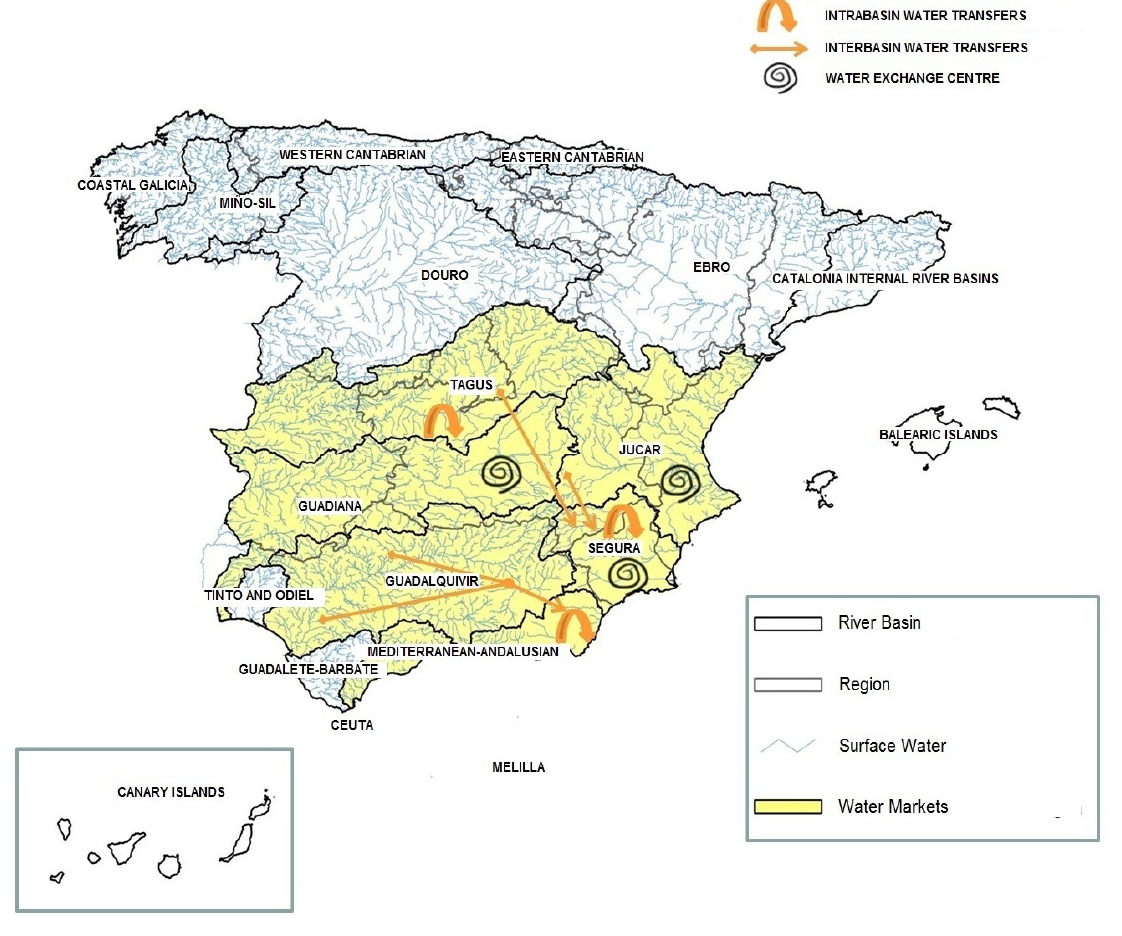
Figure 1. Location of water markets in